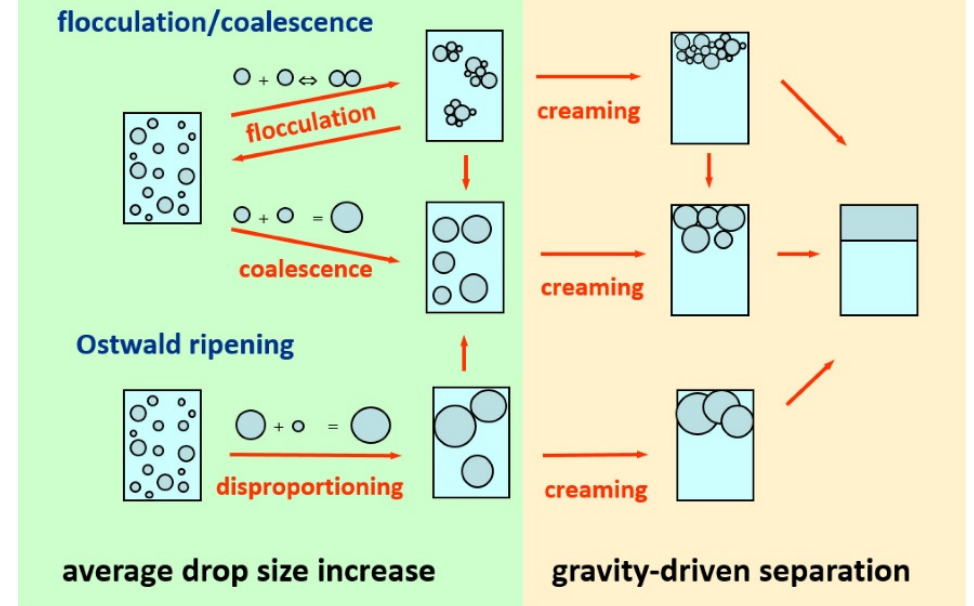
Figure 3. Sketch of some destabilization mechanisms that can drive the phase separation in emulsions. Notice that sedimentation and creaming are similar processes and do not occur simultaneously, depending on the emulsion nature. Therefore, for the sake of example, only the creaming is shown in the sketch. Reprinted from Ravera et al. [3], Copyright (2021), with permission from Elsevier.